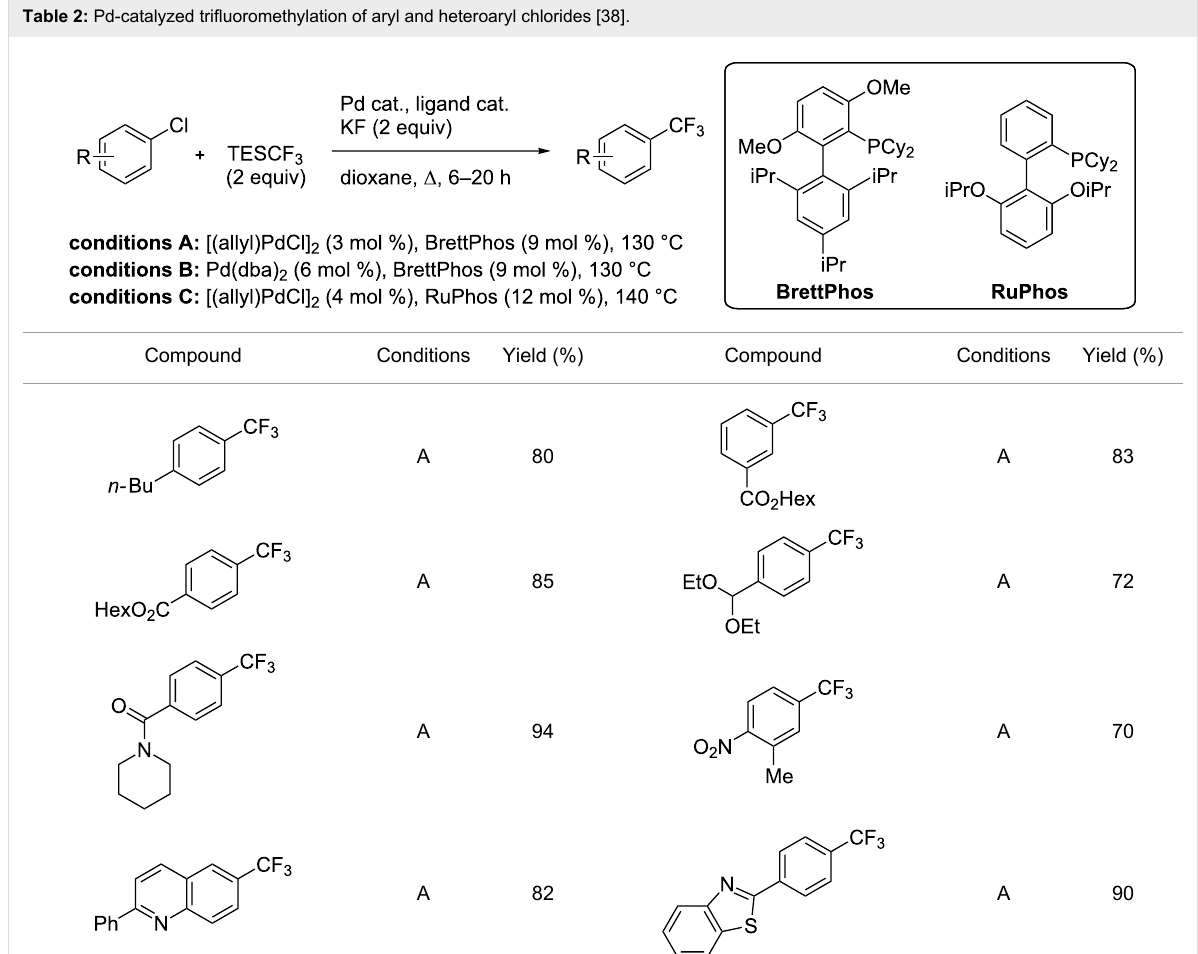
Table 2: Pd-catalyzed trifluoromethylation of aryl and heteroaryl chlorides